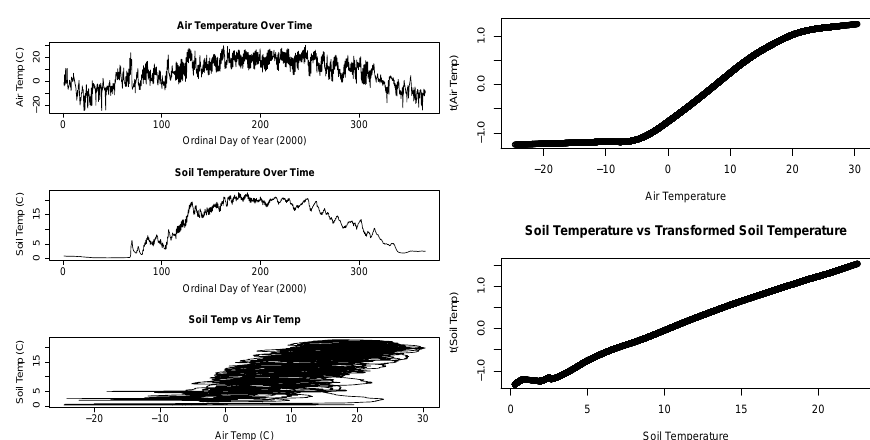
Fig. 1. First example illustrating the application of the ACE algorithm to input data (left – x over time, y over time, x vs. y ), and the resulting point pair output (right – top: [ x,f (x) ] ; bottom: [ y,g(y) ] ).